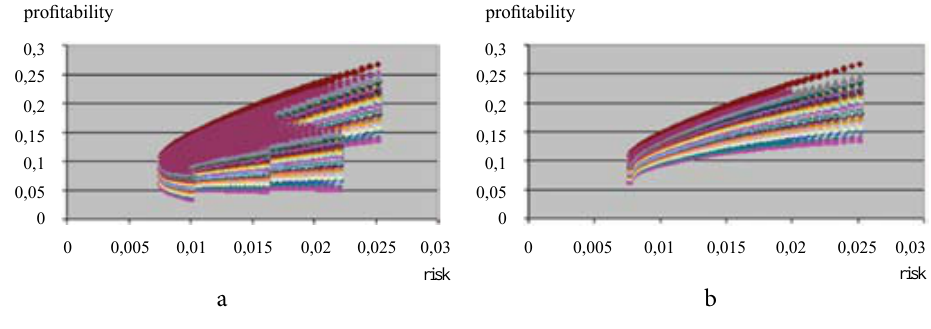
Fig. 2. Elements of the adequate